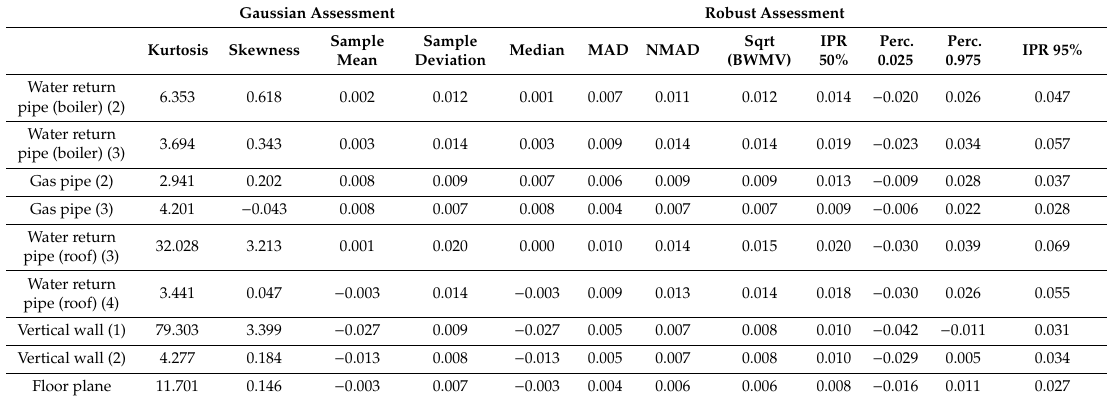
Table 7. Gaussian vs. Robust statistical analysis: Di ff erent regions analyzed (1–4) comparing the